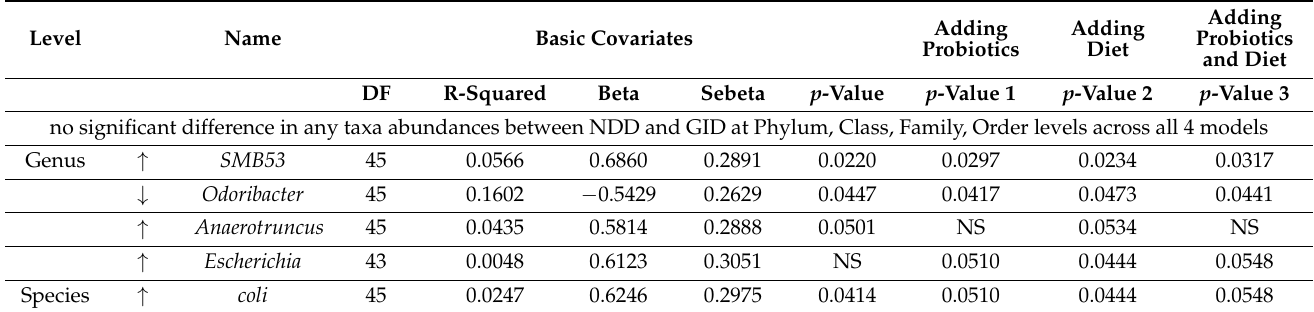
Table 6. Significant absolute abundances of bacterial taxa in NDD compared to GID.